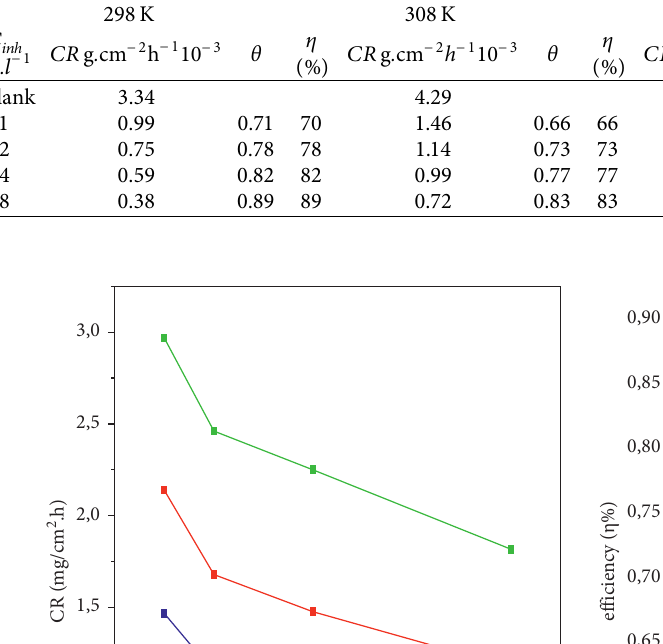
Table 1: Carbon steel corrosion weight loss results in a 1M HCl solution in the absence and presence of different inhibitor concentrations and EEW temperatures from 298 to 328 K.